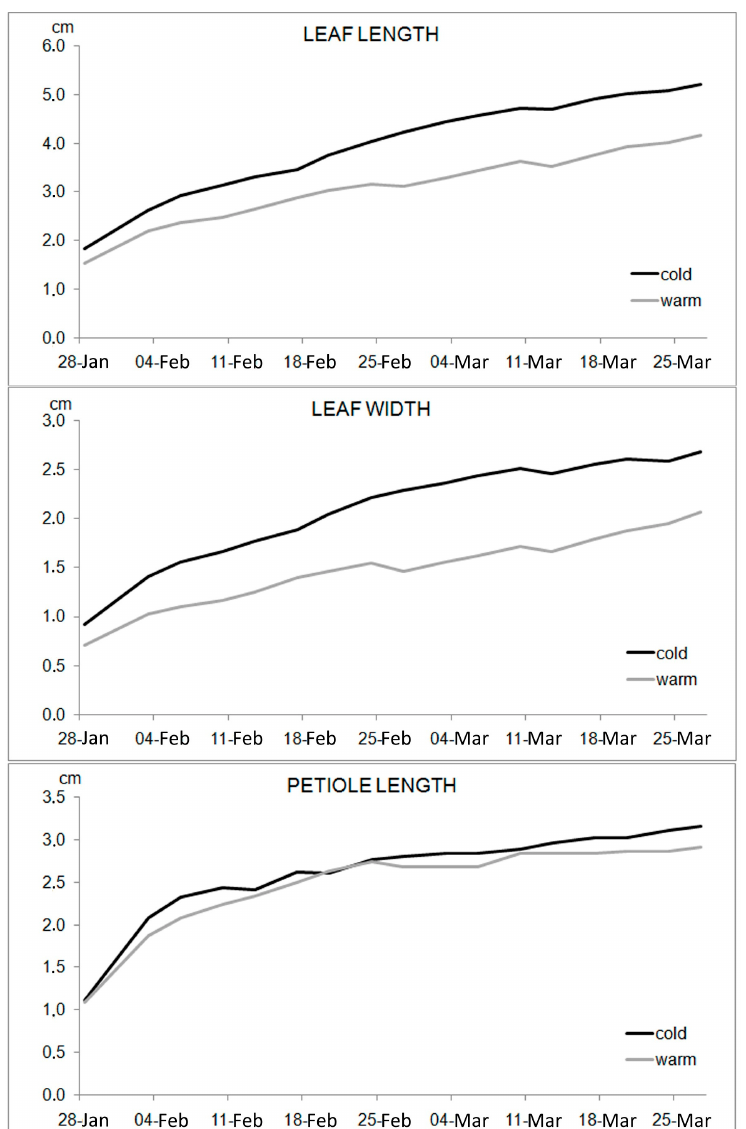
Figure 4. Mean growth of 40 leaves under the two lighting conditions: leaf length, leaf width, and stem length.